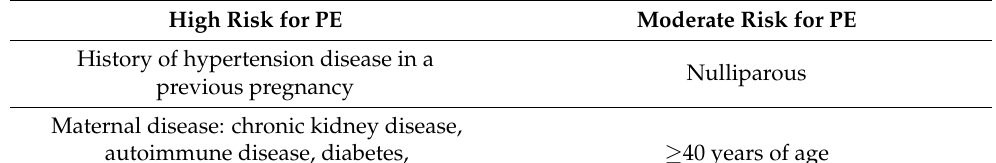
Table 4. NICE stratification of risk factor for PE [50]. High Risk for PE Moderate Risk for PE History of hypertension disease in a previous pregnancy Maternal disease: chronic kidney